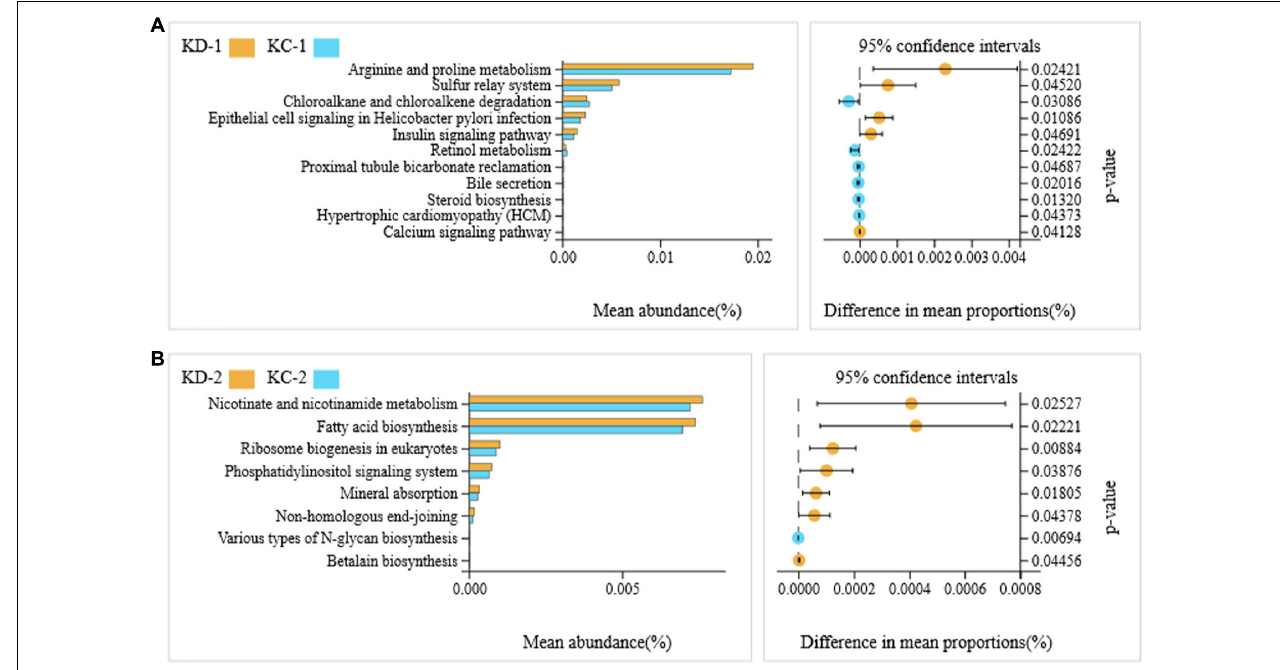
FIGURE 4 | KEGG pathways for bacteria in jejunal meconium of neonatal piglets before suckling. KD-1: bacteria of jejunal meconium of Hoxa1 − / − neonatal piglets from the control group. KC-1: bacteria of jejunal meconium of Hoxa1 − / − neonatal piglets from the experimental group. KD-2: bacteria of jejunal meconium of non-Hoxa1 − / − neonatal piglets from the control group. KC-2: bacteria of jejunal meconium of non-Hoxa1 − / − neonatal piglets from the experimental group. (A) Hoxa1 − / − piglets. (B) Non-Hoxa1 − / −